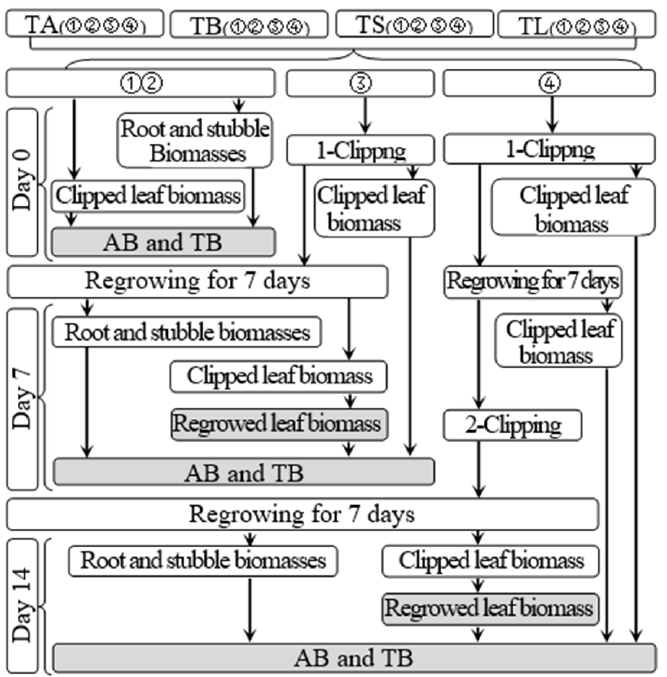
Figure 2. Schematic diagram for the measurement of biomass. TA, TB, TS, TL indicate treatments of regrowth with liquid medium without AOB added relatively long before defoliation, regrowth with liquid medium without AOB added shortly before defoliation, regrowth with S2_8_1 strain inoculated relatively long before defoliation, and regrowth with S2_8_1 strain inoculated shortly before defoliation, respectively. “ ① ”, “ ② ”, “ ③ ”and “ ④ ” show the first, second, third and fourth subgroups of each treatment, respectively. “day 0”, “day 7”, and “day 14”, respectively stand for the beginning, 7th day, 14th days of the 14-day regrowth period. “AB” and “TB” refer to accumulated aboveground and total biomasses, respectively.